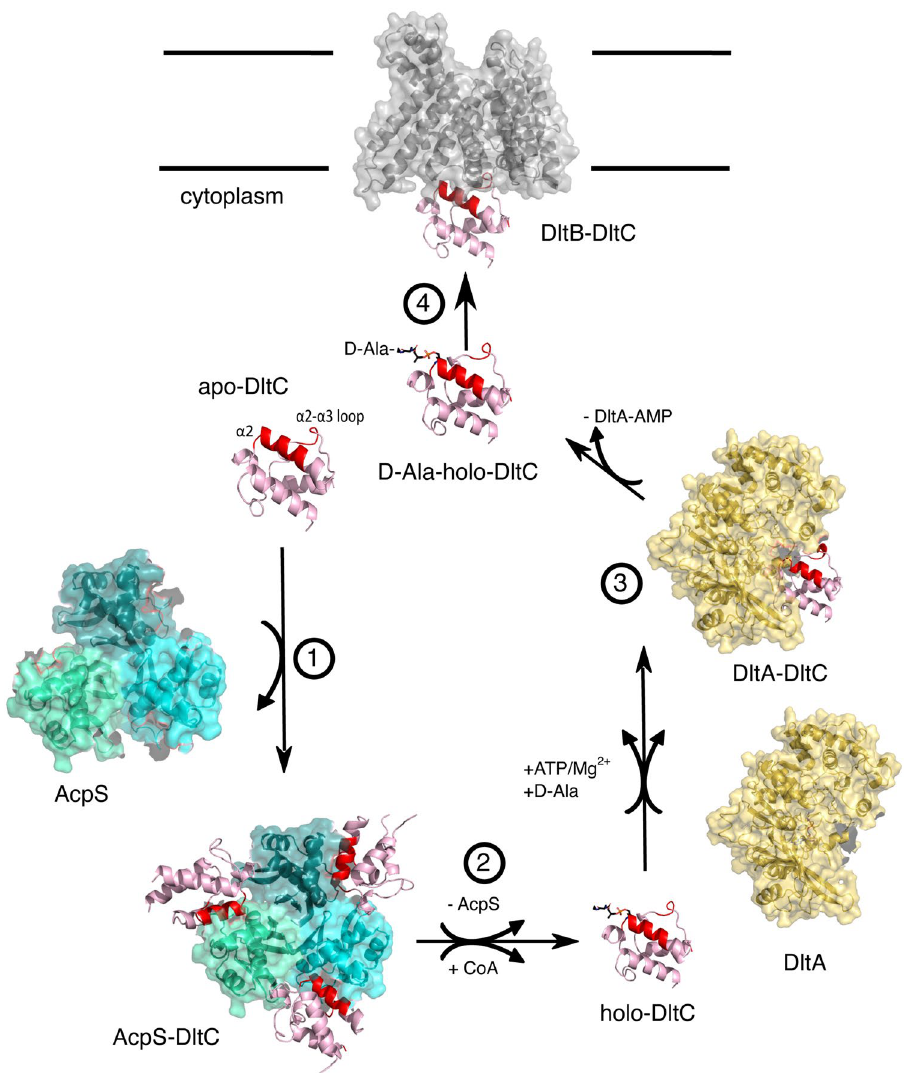
Figure 5. Structural basis of the molecular mechanism of the cytoplasmic steps of the TA d-alanylation pathway. DltC engages its helix α2 and the loop connecting α2 and α3 (binding surface—BS colored in red) to bind the Phosphopantetheinyl transferase AcpS and form a 3:3 stoichiometry AcpS-DltC complex ( step 1 ). After the transfer of a CoA molecule by AcpS on the catalytic Ser38 of each DltC molecule, the newly formed holo- DltC detaches from AcpS ( step 2 ). Holo-DltC can then interact through the same binding surface (BS colored in red) with DltA in its adenylation state. DltC binds at the interface between the large N-Terminal domain and the small C-terminal domain of DltA and exposes the Ppant moiety covalently bound to Ser38 in front of the binding site of DltA containing a AMP-d-Ala substrate to allow the transfer of the d-alanyl group to the distal end of the Ppant ( step 3 ). Finally, DltC harboring the d-Ala-bound Ppant is released from DltA and can bind to DltB with the same binding surface as the one mediating the interaction with DltA and AcpS ( step 4 ). The d-Ala-Ppant attached in its extended conformation to DltC will then fit in the DltB funnel to allow the d-Ala transfer in the extracellular